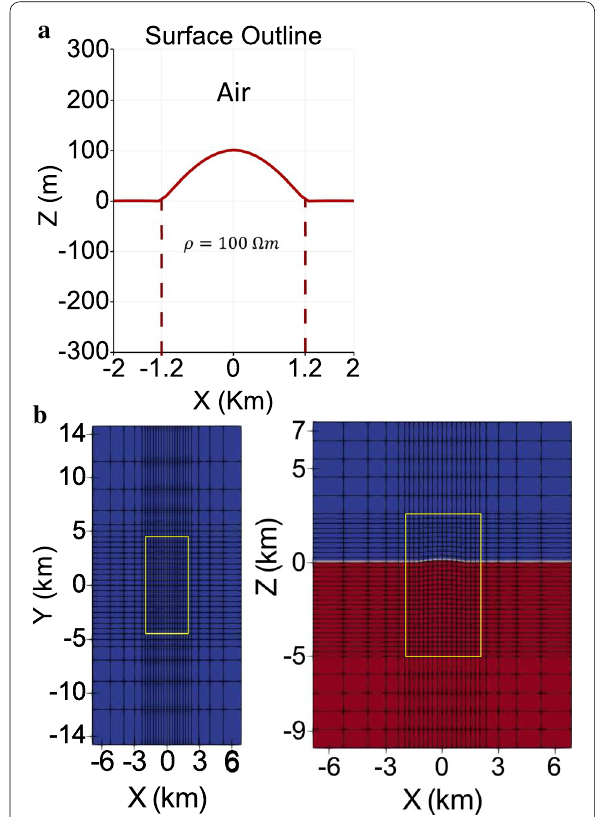
Fig. 11 2D topography input model. a Geometry of the setup from a vertical cross‑section, showing the topography of the model. The hill is a smooth vertical extension to a homogeneous background with ρ = 100 � m , with a variable symmetric height profile reaching up to 100 m, and a lateral extent in x direction of 2.4 km. Input model dimensions are 4 × 10 × 5 km. b The model domain is indicated by a yellow rectangle. Air height is 2.5 km, and the depth of the input model is increased by 5 km. The spacing for the inner grid is of d x = 250 m, d y = 500 m, and d z = 250 m. The width of the boundary regions surrounding the inner model are 4.9 km in the x and z directions, and 9.75 km in the y direction. This computational grid has dimensions of x ∈ [− 6.9,6.9 ] km, y ∈ [− 14.75,14.75 ] km, and z ∈ [ 0,17.35 ] km